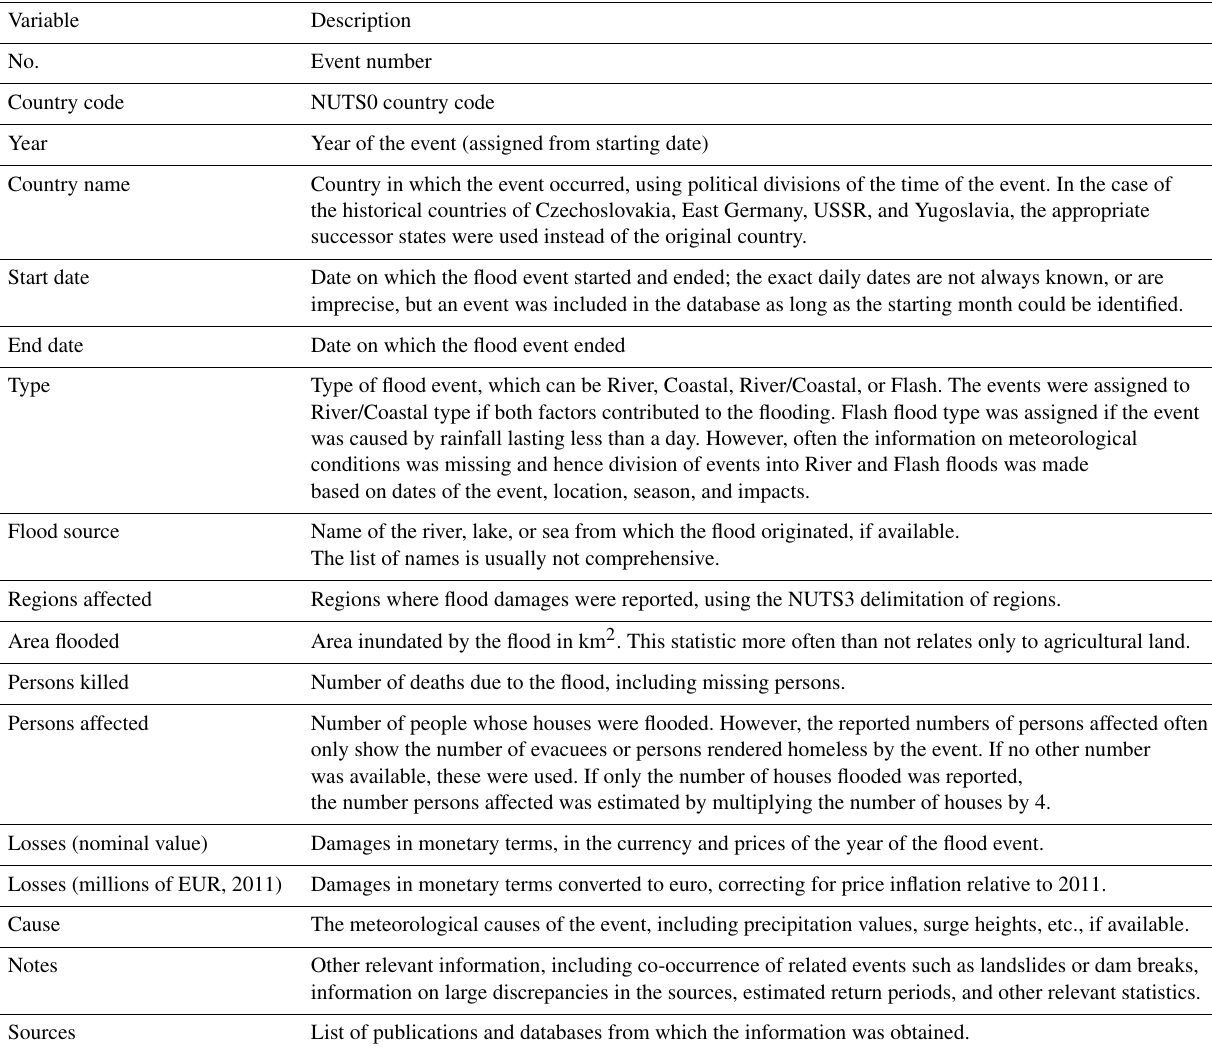
Table 5. Information included in HANZE-Events